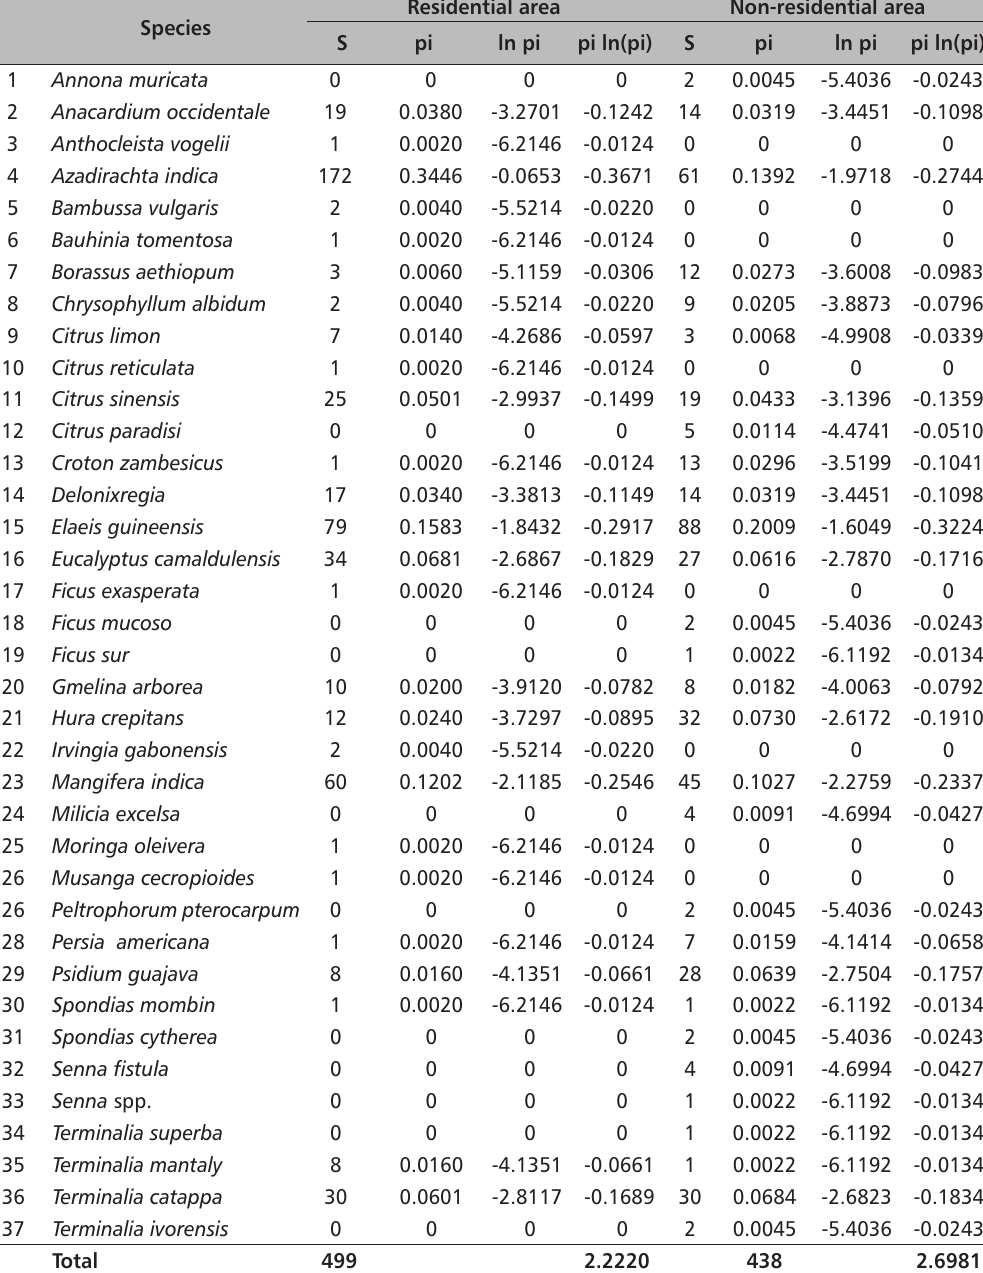
TABLE 3. Species diversity (Shannon and Wiener’s diversity index) of ethno-medicinal tree in University of Port Harcourt, Nigeria Residential Species